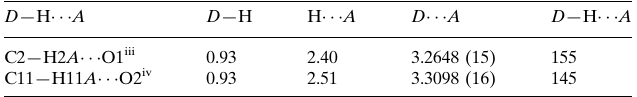
Hydrogen-bond geometry (A˚ , (cid:2)